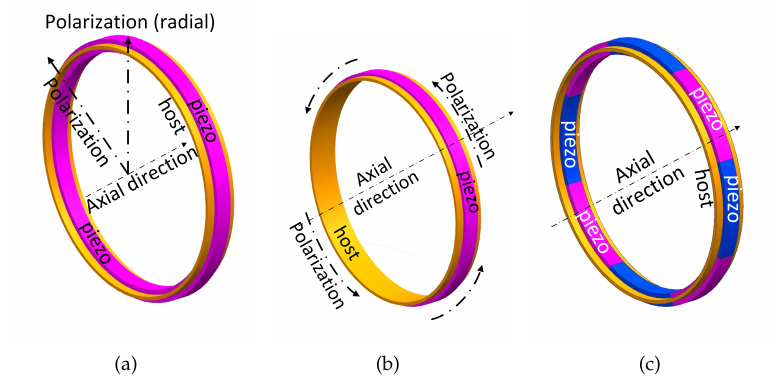
Figure 16. Transducer designs for (a) L 0 , (b) T 0 , and (c) F 4 . ( a ) double layer, radial polarization. ( b ) single layer, circumferential polarization. ( c ) double layer, radial polarization; different colors indicate reverse polarization.